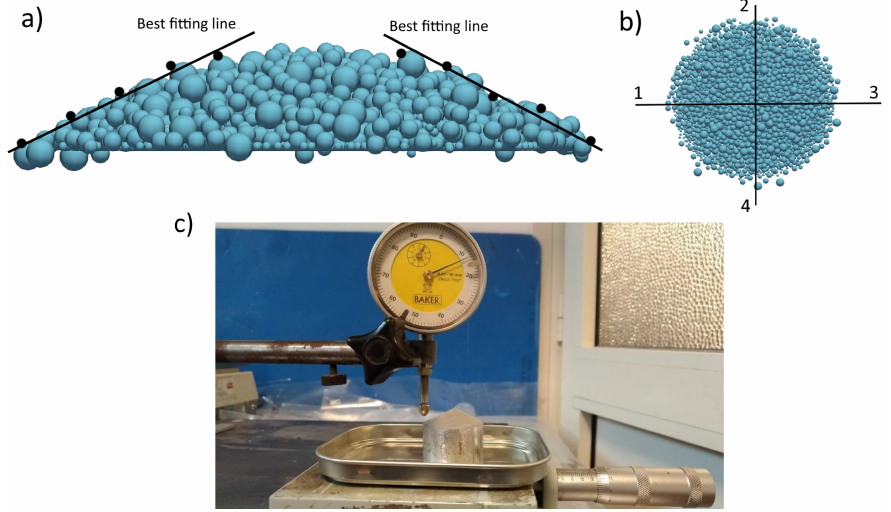
Figure 2. Procedure for the determination of the angle of repose of the powder pile. ( a ) Example of how the best fitting line is obtained ( b ) The orthogonal directions along which the angle of repose is computed. ( c ) Experimental setup for the calculation of the angle of repose.